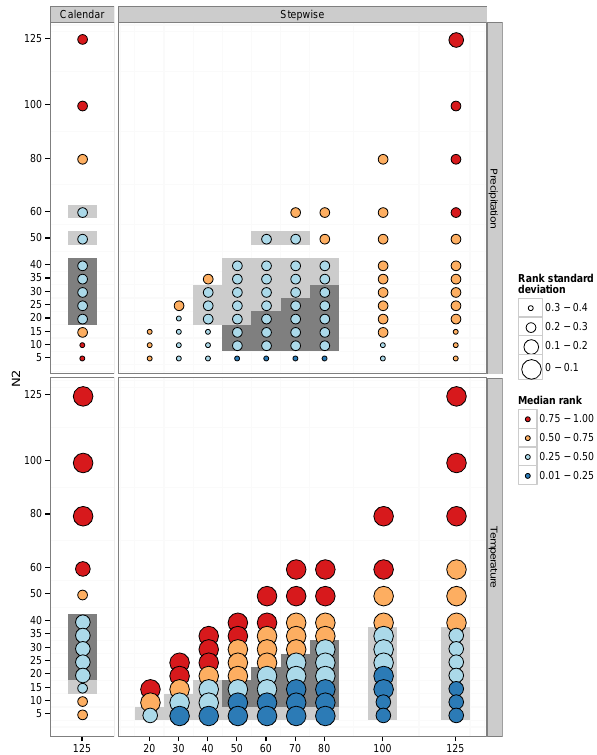
Figure C1. Normalized median ranks over France of RMSE skill scores and normalized standard deviations of these ranks for each N 2 (calendar selection, left) and each N 1– N 2 (stepwise selection, right), and for precipitation (top) and temperature (bottom). Light grey rectangles highlight ranks lower than 0.5 independently for precipitation and temperature. Dark grey rectangles highlight ranks lower than 0.5 for both precipitation and